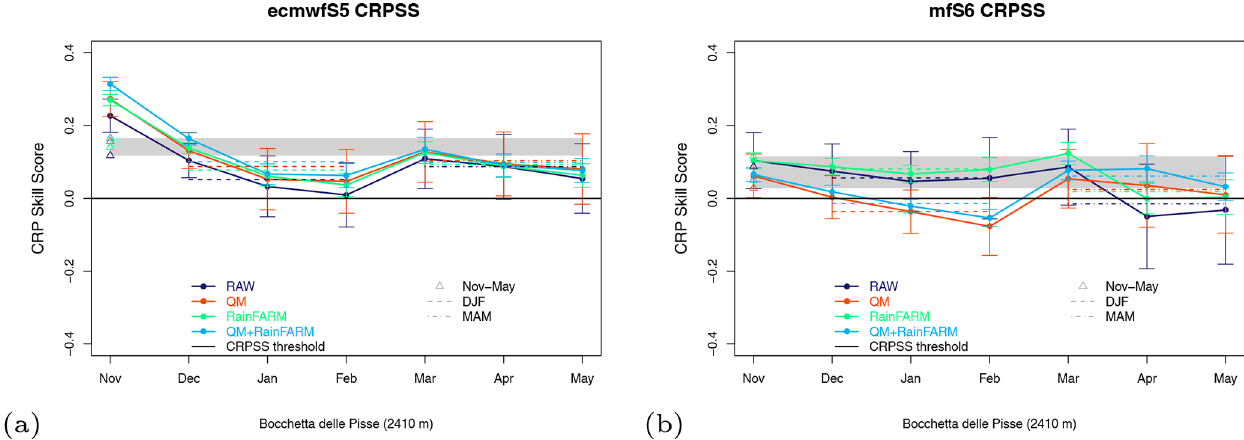
Figure 11. CRPSS for seasonal forecasts of monthly and seasonally averaged snow depth for (a) ECMWFS5 and (b) MFS6 forcing, start- ing date 1 November, lead times from 1 to 7 months, for the site of Bocchetta delle Pisse. Coloured dots represent the scores for each month and each experiment; dashed (dotted-dashed) horizontal lines represent DJF (MAM) scores; and the grey-filled rectangle and the four coloured triangles all refer to the seasonal (November–May) snow depth forecasts, and they indicate the score spread among the four different experiments and the score for each of the four experiments,